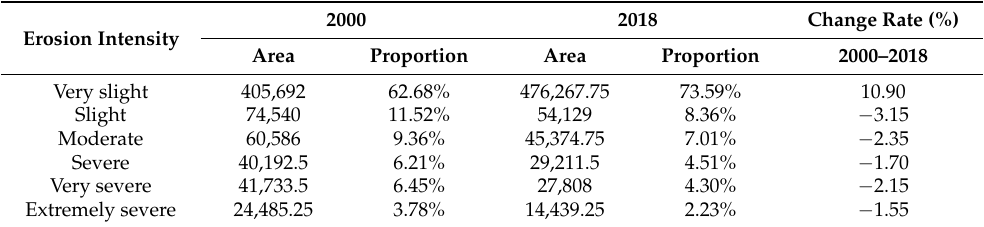
Table 3. Area statistics and changes in the soil erosion intensity class in the Loess Plateau from 2000 to 2018 (unit: km 2